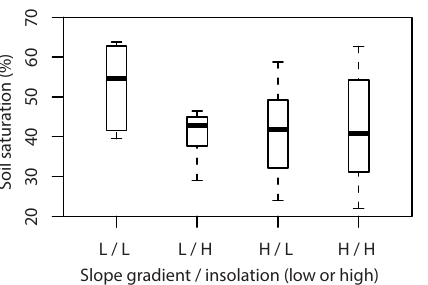
Figure 7. Box plots of soil saturation (mean of 10–40cm soil depth) on 6–8 April 2008. For calculating the box plot statistics, the hill- slope sites were stratified into four groups combining low or high slope gradient (less than or greater than the mean gradient) with low or high solar radiation (less than the lower quartile or greater than the upper quartile of mean potential solar radiation throughout the snow-free season).